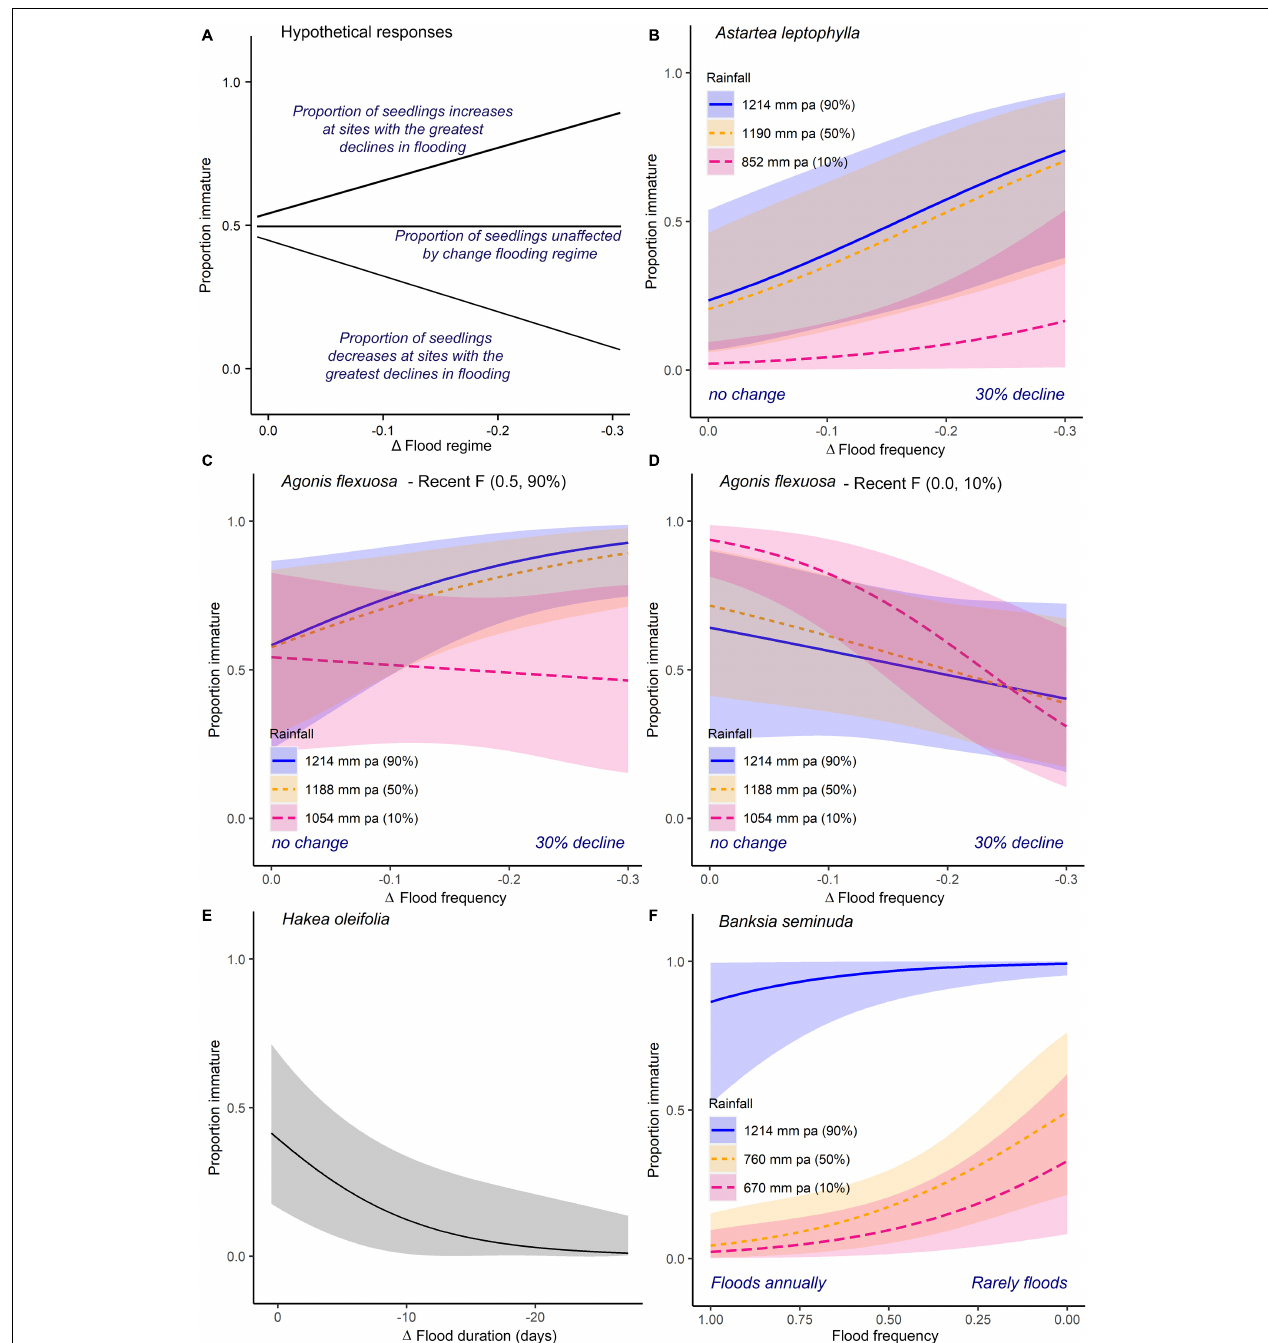
FIGURE 4 | Variation in the relative frequency of immature to mature individuals of riparian tree and shrub species modeled as a function of their hydrological conditions. A positive slope indicates an increasing likelihood of immature individuals being found at sites experiencing a greater decline in flooding; conversely, a negative slope indicates a decreasing likelihood of immature individuals being found at sites experiencing a greater decline in flooding. Hydrological parameters examined include mean annual rainfall (mm pa, percentiles), recent flood frequency (for the period 2001 to 2010), and the change in flood frequency (between two the ten-year periods 1980 to 1989 and 2001 to 2010). Flood frequency is presented as the probability that individuals are likely to be inundated at least once in any one calendar year, where 1 indicates annual flooding and 0 indicates individuals were never flooded. The fitted lines ( ± 95% confidence intervals) represent the 10th, 50th, and the 90th percentiles of model predictions from binomial generalized linear mixed effects models (see methods for details). Note that percentiles for each predictor vary between species because each species is distributed over a distinct rainfall or hydrological range. (A) Presents hypothetical responses of a plant species to declining flooding regimes. Models are presented for (B) the riparian shrub Astartea leptophylla ; the canopy tree Agonis flexuosa under (C) the 90th percentile and (D) the 10th percentile of the recent flood frequency; (E) the facultative riparian trees, Hakea oleifolia and (F) Banksia seminuda .